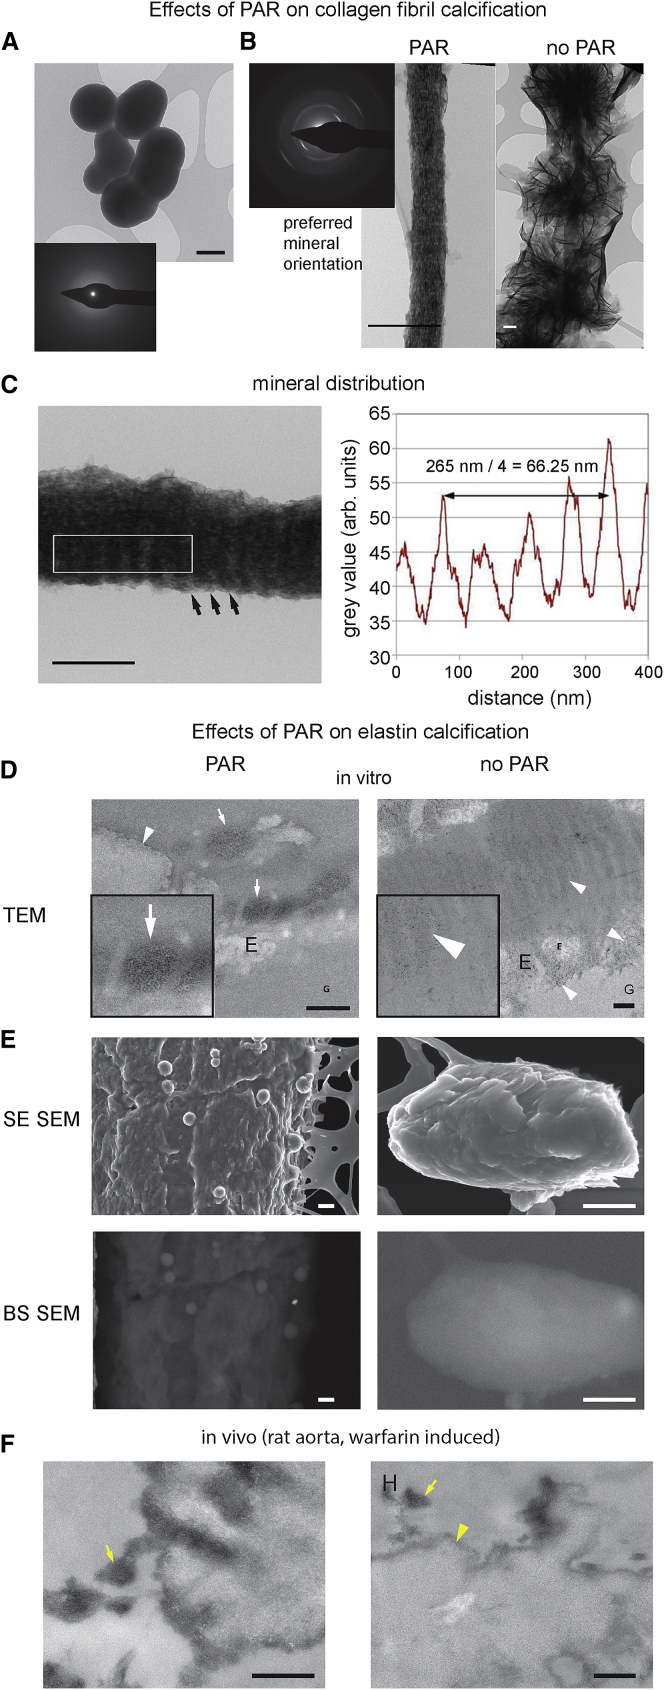
PAR Can Induce Calcification of Extracellular Matrix Components(A) TEM image of PAR with 4.5 mM Ca2+ (CaCl2), 2.1 mM PO43− (K2HPO4) TRIS buffered solution showing spheres, similar to the calcium-rich PAR spheres seen after incubation with CaCl2 alone. Scale bar, 100 nm.(B) TEM images of the mineral resulting from co-incubation of collagen fibrils in the presence (left) or absence (right) of PAR in vitro with a buffered solution containing 4.5 mM Ca2+ and 2.1 mM phosphate for 14 days. Scale bars, 250 nm. See also Figure S5A.(C) Higher TEM magnification (left) showing the periodicity (arrows) of the mineral deposition in the PAR-calcified collagen fibrils (unstained). Density plot (right) taken from the boxed area shows the distance between maxima was ∼66 nm.(D and E) TEM (D) and SEM (E) of resin thin section of elastin + PAR and elastin alone incubated in Ca2+ and PO43− solutions for 14 days. White arrowheads in TEM images indicate fine, electron-dense material; white arrows denote larger areas of electron-dense material. G, gelatine; E, elastin. Secondary electron (SE) SEM images of elastin + PAR samples to assess the surface topography of elastin after incubation show numerous spheres on elastin surfaces, and elastin alone does not. Backscattered (BS) images show electron-dense areas as lighter, and they show the elastin + PAR sample spheres are electron dense and that the surface of elastin-alone samples is covered with diffuse, electron-dense material. See Figure S5B for controls and Figure S5C for more images.(F) Block-face SEM images of rat medial aorta calcification induced by warfarin diet. Yellow arrows indicate areas of electron-dense material.Scale bars, 500 nm for (D)–(F).